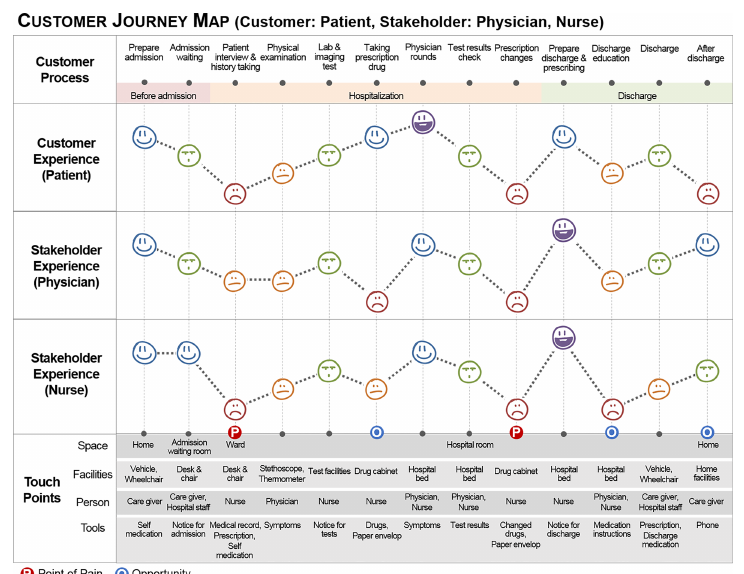
Fig 2. The customer journey maps of a patient, a physician, and a